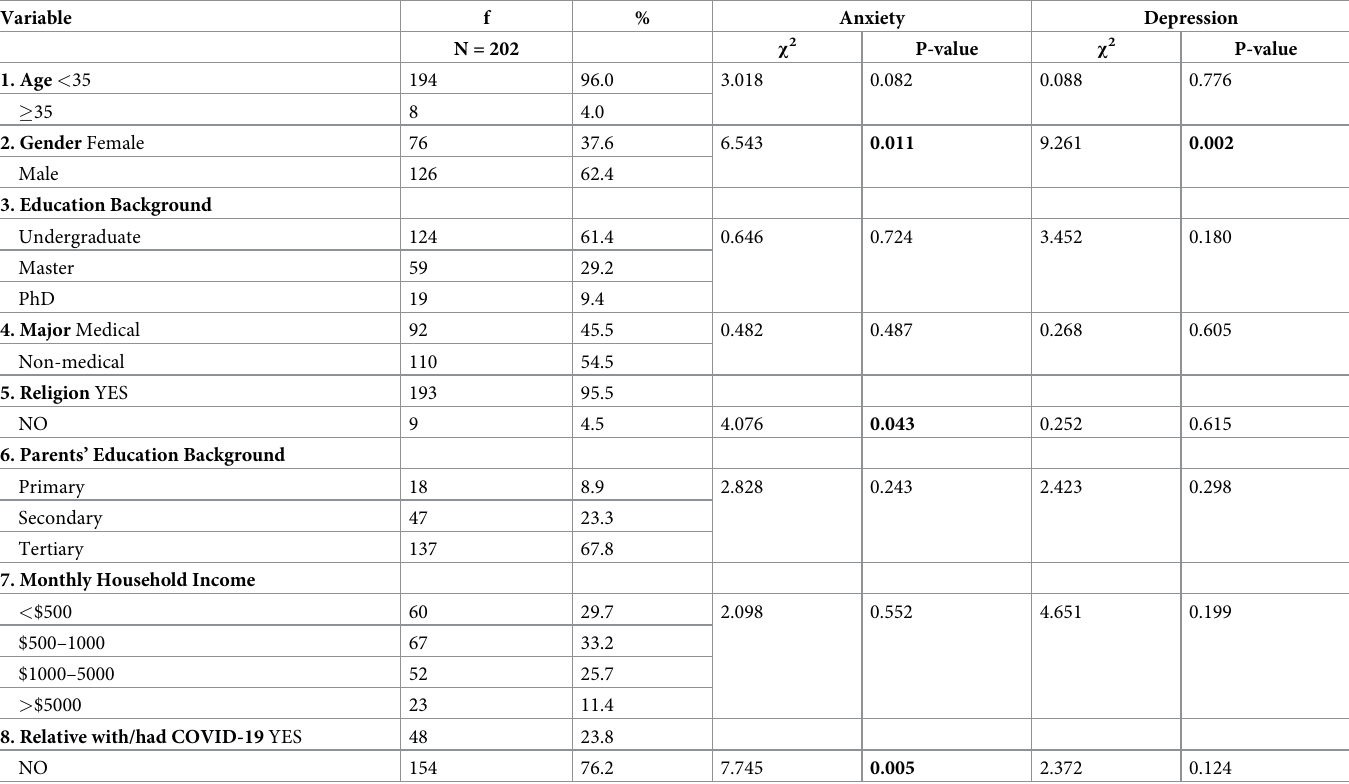
Table 6. Descriptive analysis of association between sociodemographic characteristics and psychological state on the Africans In China group.